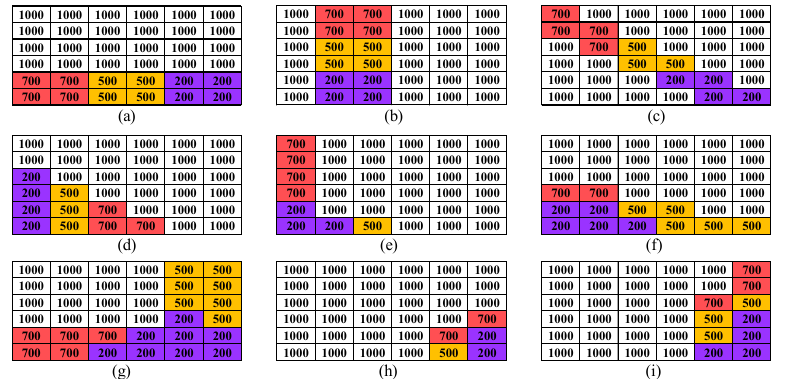
Figure 5. Partial shading conditions ( a ) case II, ( b ) case III, ( c )case IV, ( d ) case V, ( e ) case VI, ( f ) case VII, ( g ) case VIII, ( h ) case IX, ( i ) case X.